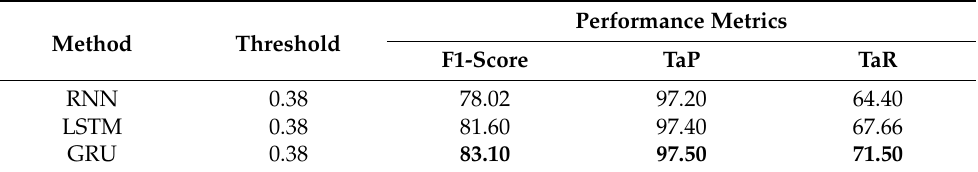
Table 5. Comparison of models based on performance metrics.